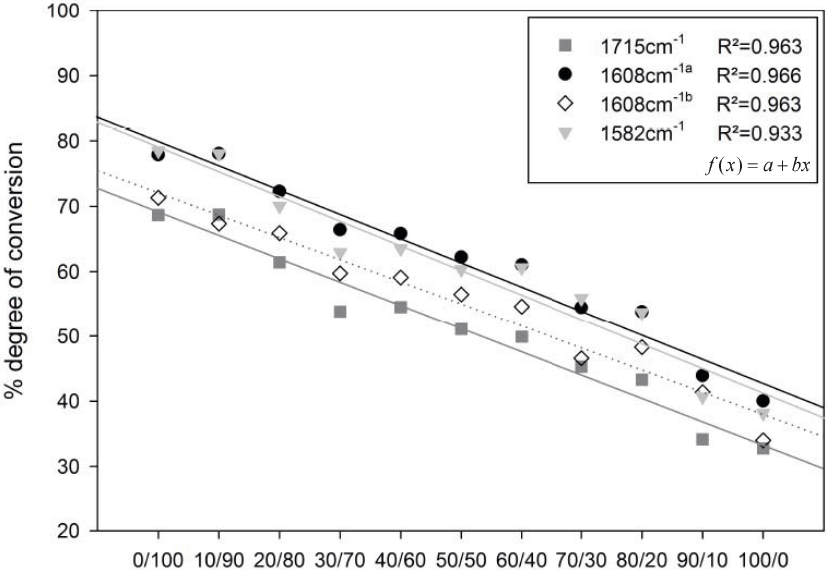
Figure 2 - Linear regression analysis to obtain the relationship between DC and proportions of BisGMA/BisEMA